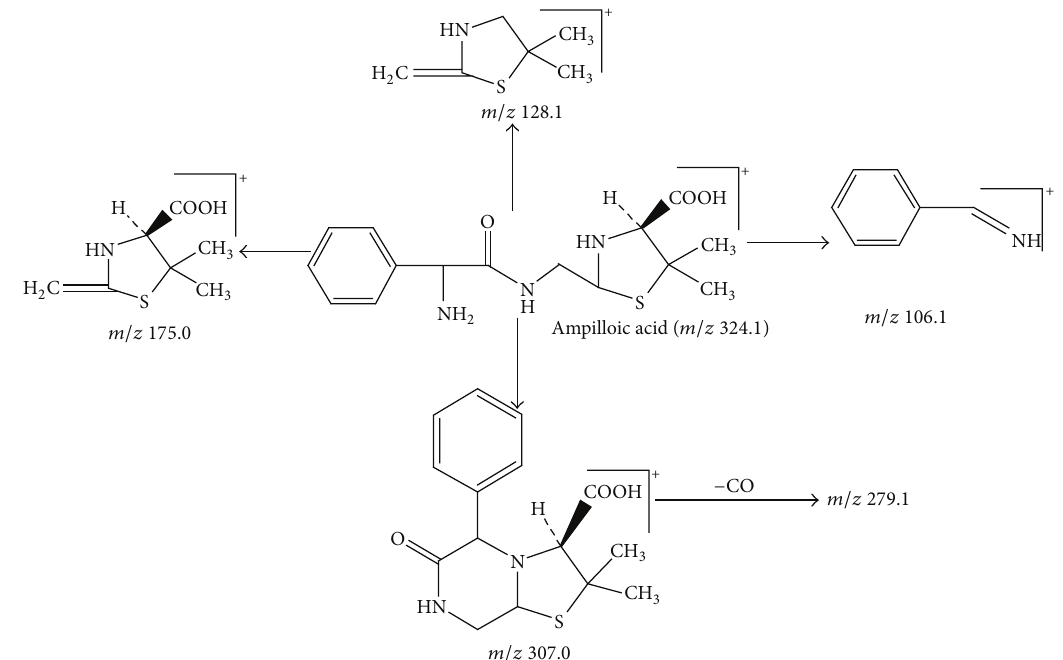
Figure 6: Proposed fragmentation pathway for the fragmentation ions of ampilloic acids.